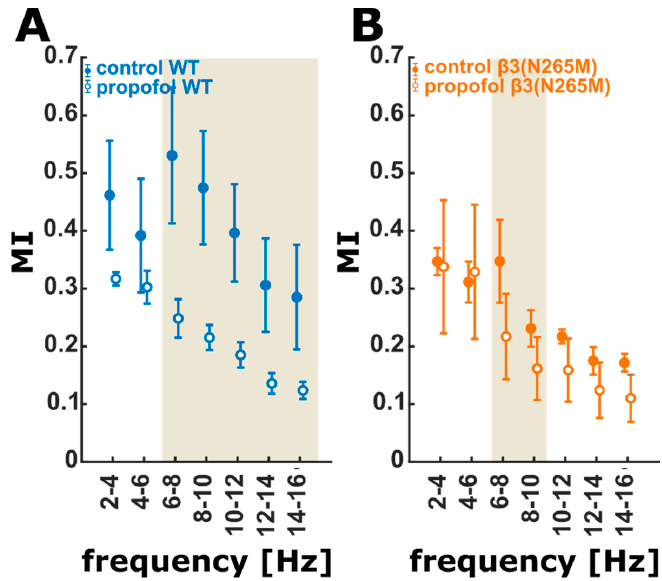
Figure 3. Propofol-induced change in mutual information MI (10 bins) in wild-type ( A ) and β 3(N265M) mice ( B ) at control conditions and in the presence of propofol. ( A ) In the wild-type analysis, propofol significantly reduces MI in frequencies above 6 Hz. The observed effects are classified as strong effects by the Hedges’ g test. ( B ) In the β 3(N265M) group propofol has a significant (medium: g < 0.8) decreasing effect on MI only in the frequency range of 6–10 Hz. The ivory areas indicate significance, i.e., a 95% confidence interval of Hedge’s g exclusive 0; wild-type ( n = 4), β 3(N265M) knock-in mice ( n = 3); MI: mutual information. The Hedges’ g values and their CI for all experiments (power spectral density (PSD), PLV, and MI) in the single frequency intervals are listed in Table 1. Table 1. The table shows the Hedges’ g values and corresponding 95% CI intervals of the comparison of spectral power, PLV, and MI at control conditions and in the presence of propofol. Grey entries are not significant. A bold representation in black indicates a significant strong effect. A bold and italic representation in black indicates a significant medium effect. PLV: phase locking value; MI: mutual information; CI: 95% confidence interval.